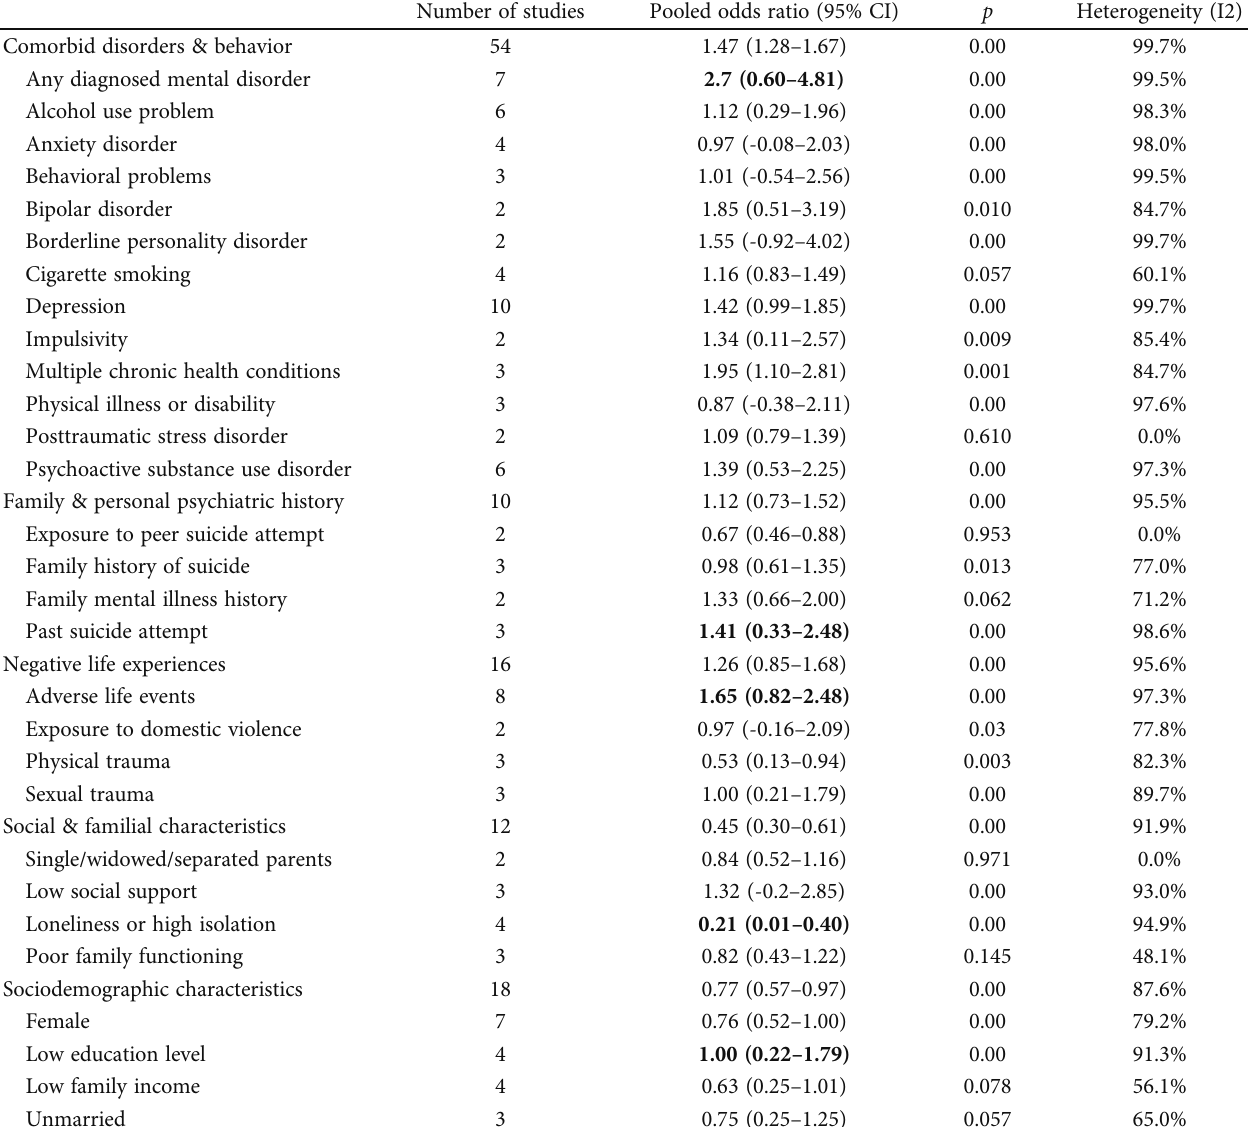
Table 2: Risk factors associated with suicide (ordered by domain) and their calculated odds